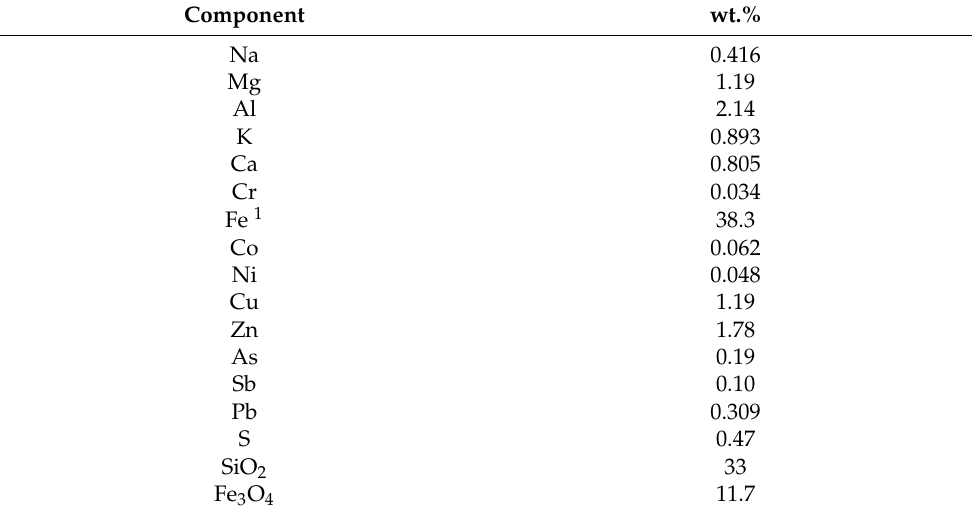
Table 2. Chemical composition of industrial Cu-slag used in this study.